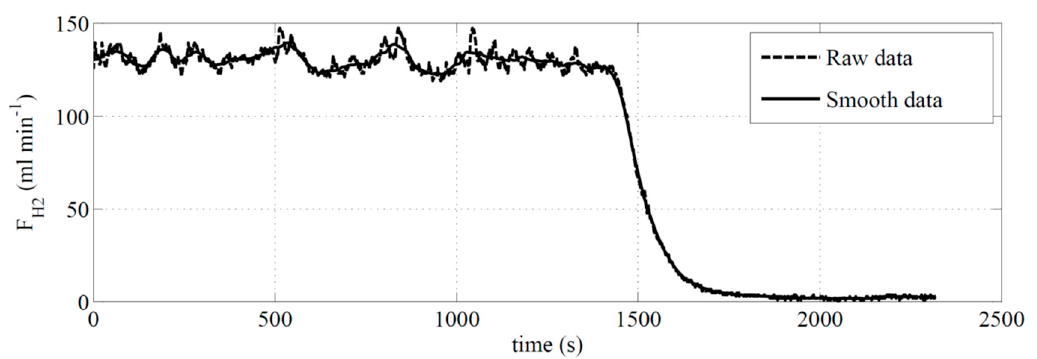
Figure 3. Reactor e ffl uent hydrogen generation rate Raw experiment data (dash line) and smooth data Figure 3. Reactor effluent hydrogen generation rate Raw experiment data (dash line) and smooth data (solid (solid line).